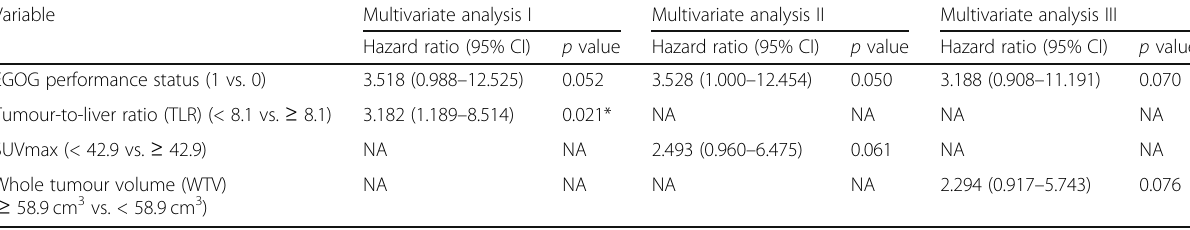
Table 5 Multivariate analysis of [ 68 Ga]Ga-DOTA-TOC PET/CT variables with ECOG performance